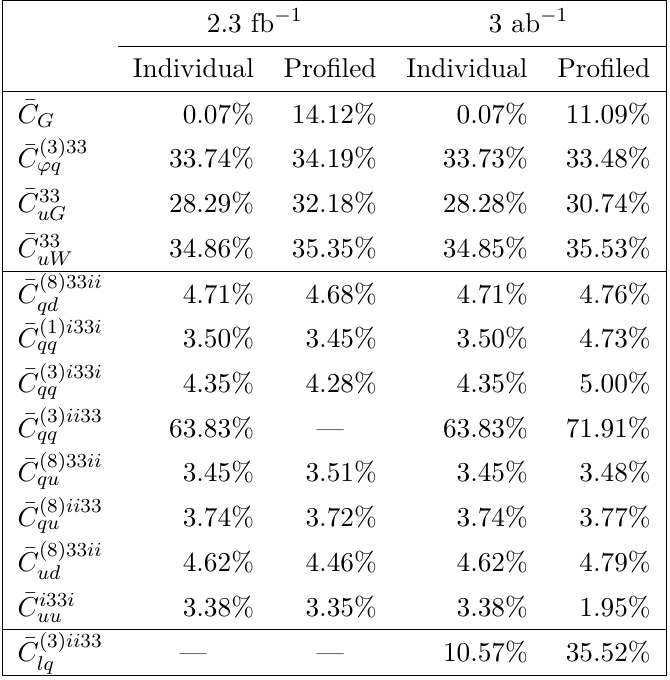
Table 3 . Maximum improvements in 2 σ bounds via a cut on the ML